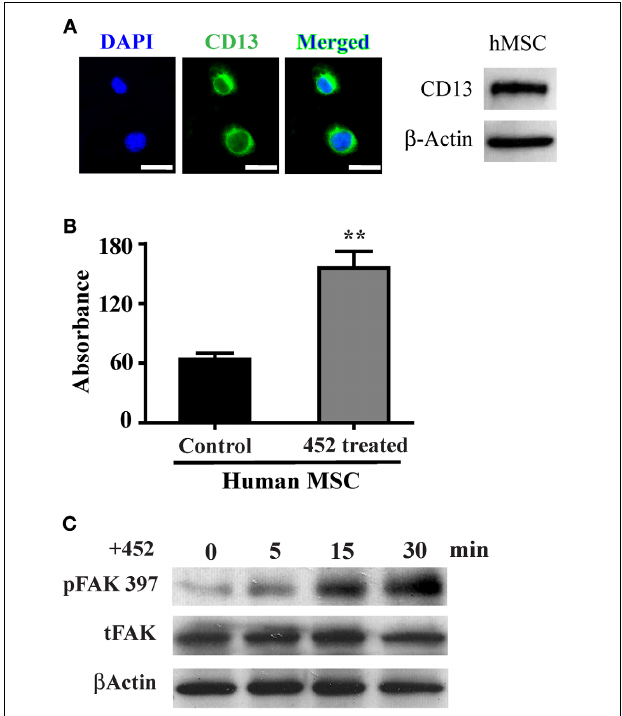
FIGURE 4 | CD13 activation increases monolayer adhesion and FAK phosphorylation in human MSCs. (A) Human mesenchymal stem cells also express CD13 by immunofluorescence (green); Objective 63X (Bar = 20 μ m) and immunoblot of human cell lysates. (B) Colorimetric quantification of adhesion of human MSCs treated with the CD13 activating mAb 452 to HUVEC monolayers. Data represents the mean ± s.e.m. n = 3 from two independent experiments ( ∗∗ P < 0 . 01). (C) CD13 crosslinking with activating mAb 452 temporally induces FAK tyrosine phosphorylation in human